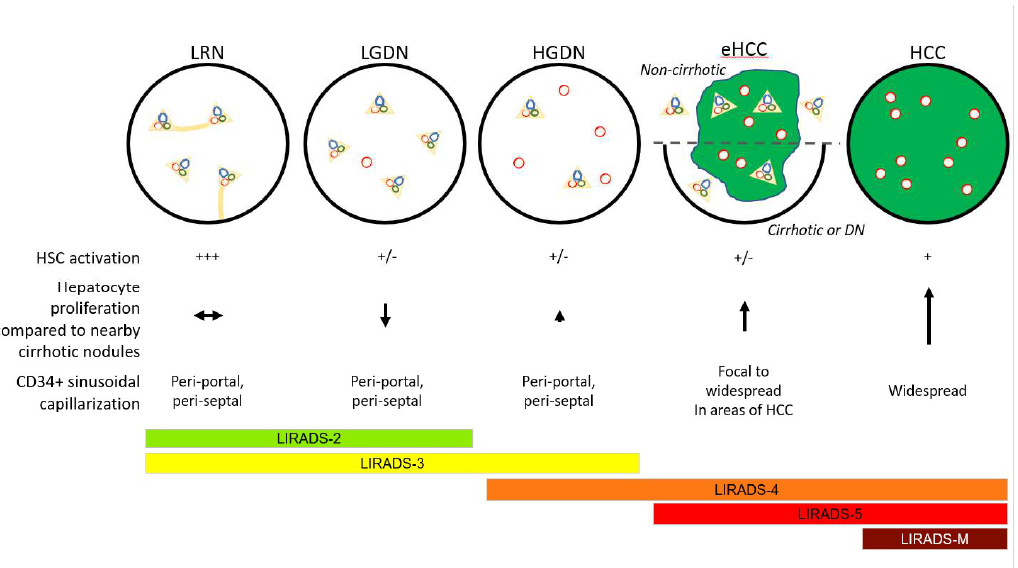
appear reactive and, therefore, abnormal.